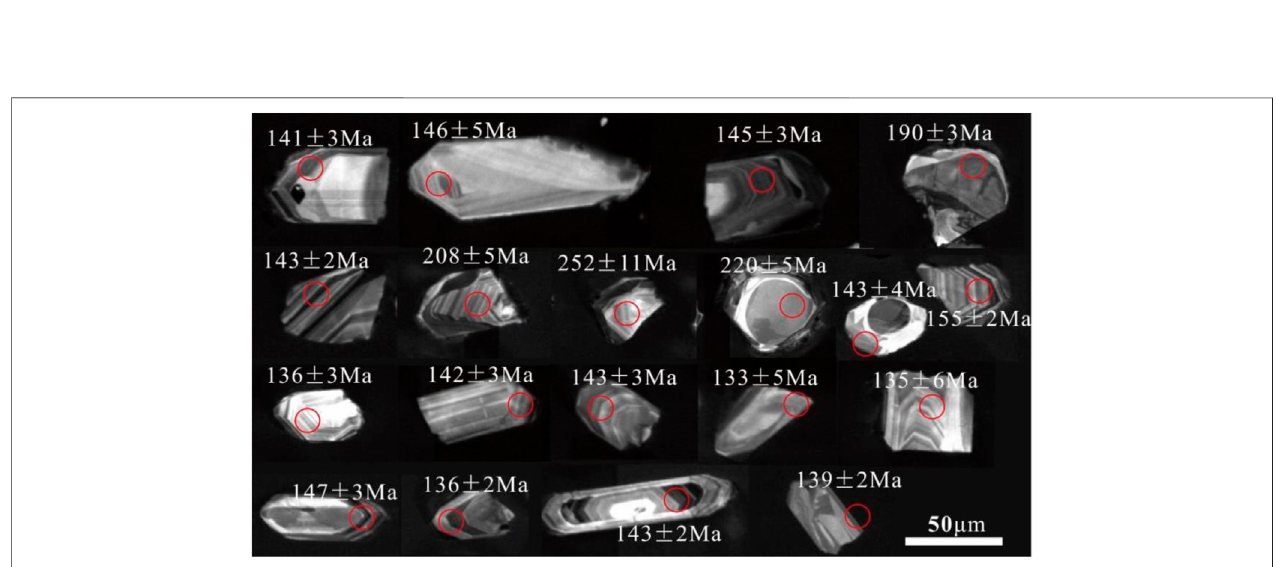
FIGURE 9 | Representative CL images for zircons from the Zhaoxian gold deposit.